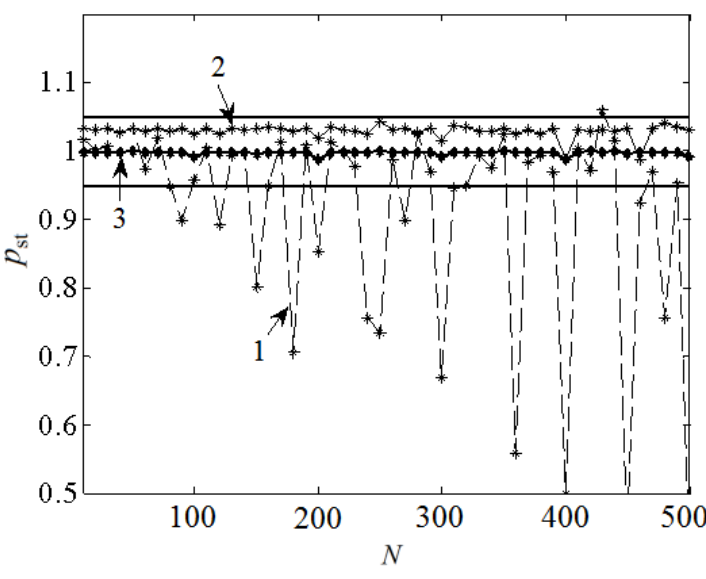
Figure 8. Effect of N on p st